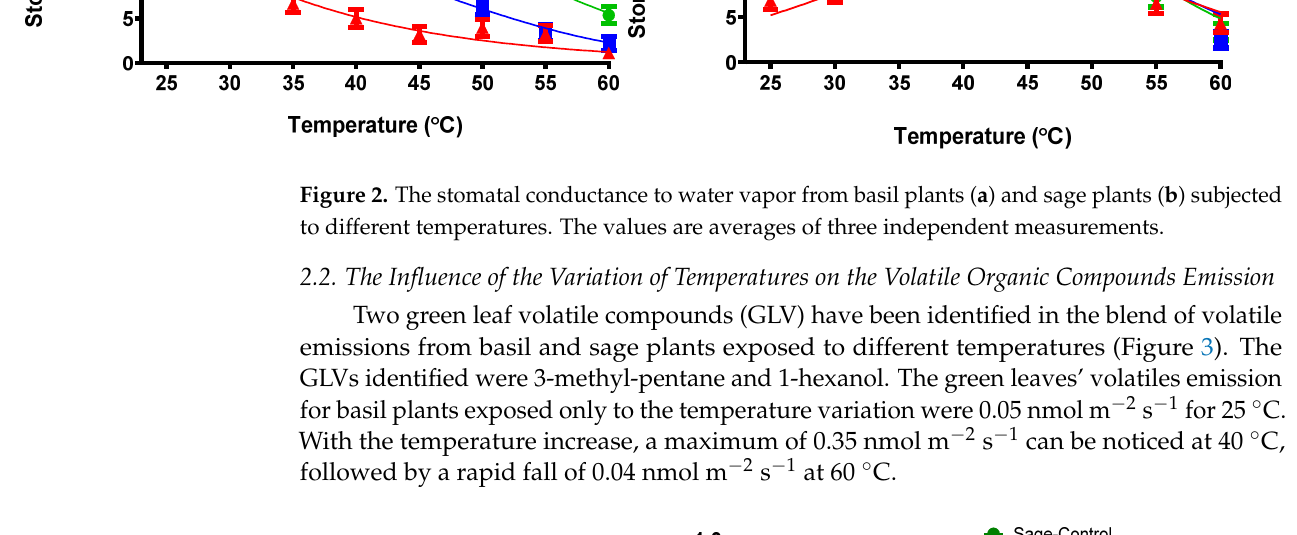
Figure 2. The stomatal conductance to water vapor from basil plants ( a ) and sage plants ( b ) sub- jected to different temperatures. The values are averages of three independent measurements.